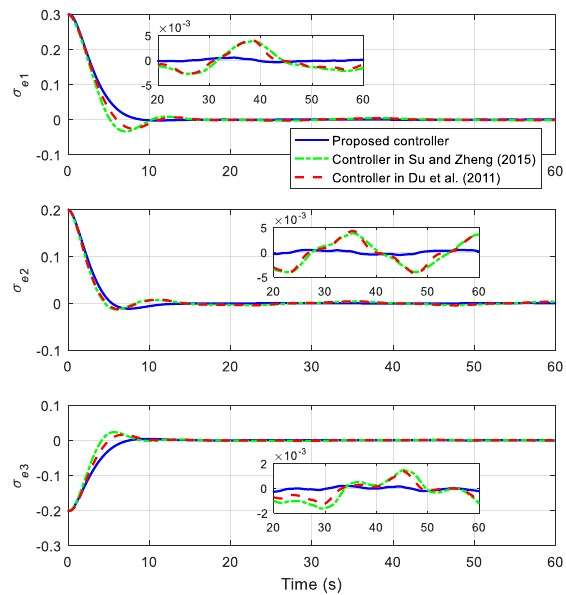
Figure 4. Profile of the attitude tracking errors σ e